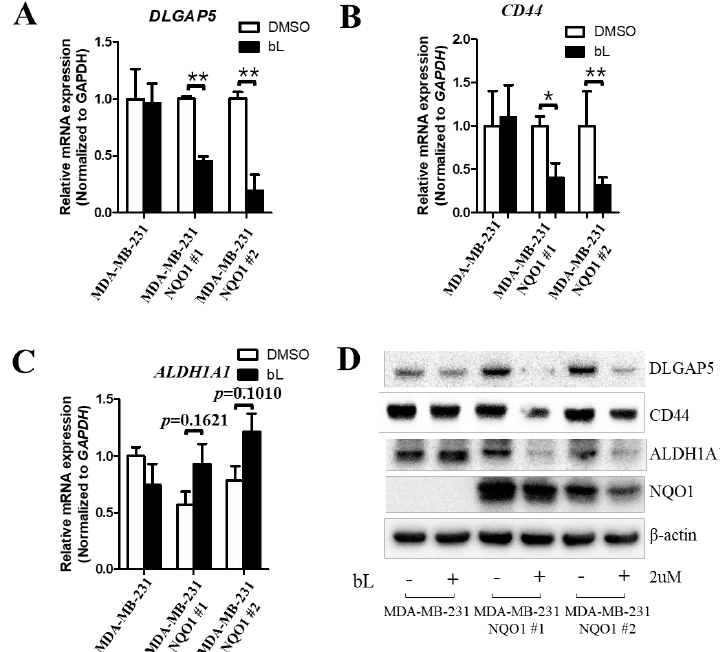
Figure 2. The β -lapachone (bL) compound suppresses the expression of BCSC markers in Figure 2. The β-lapachone (bL) compound suppresses the expression of BCSC markers in an NQO1- dependent manner. ( A – C ) The mRNA expression levels of DLGAP5, CD44, and ALDH1A1 were